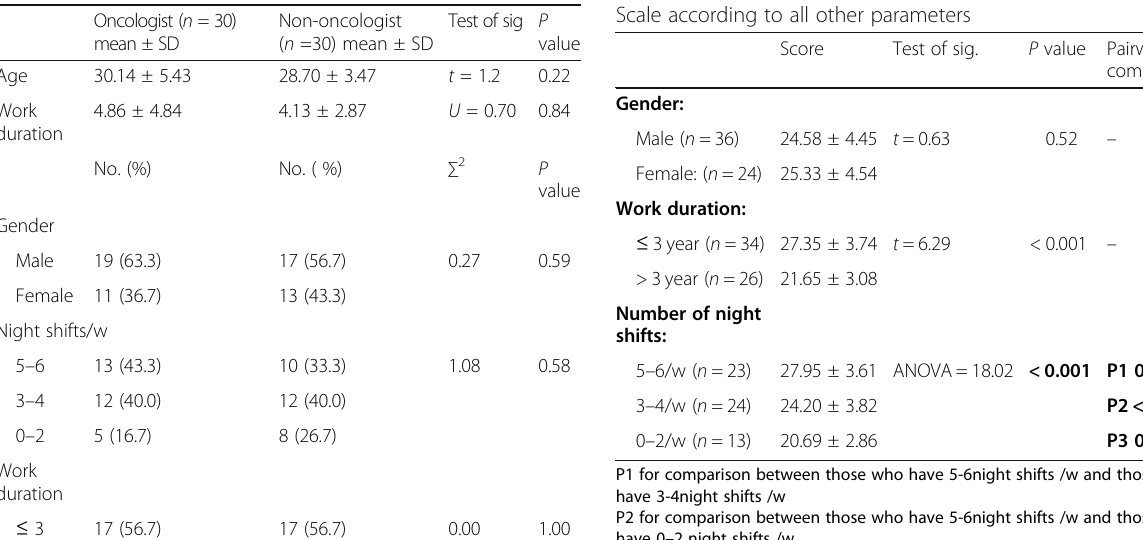
Table 1 Descriptive statistics of the studied groups